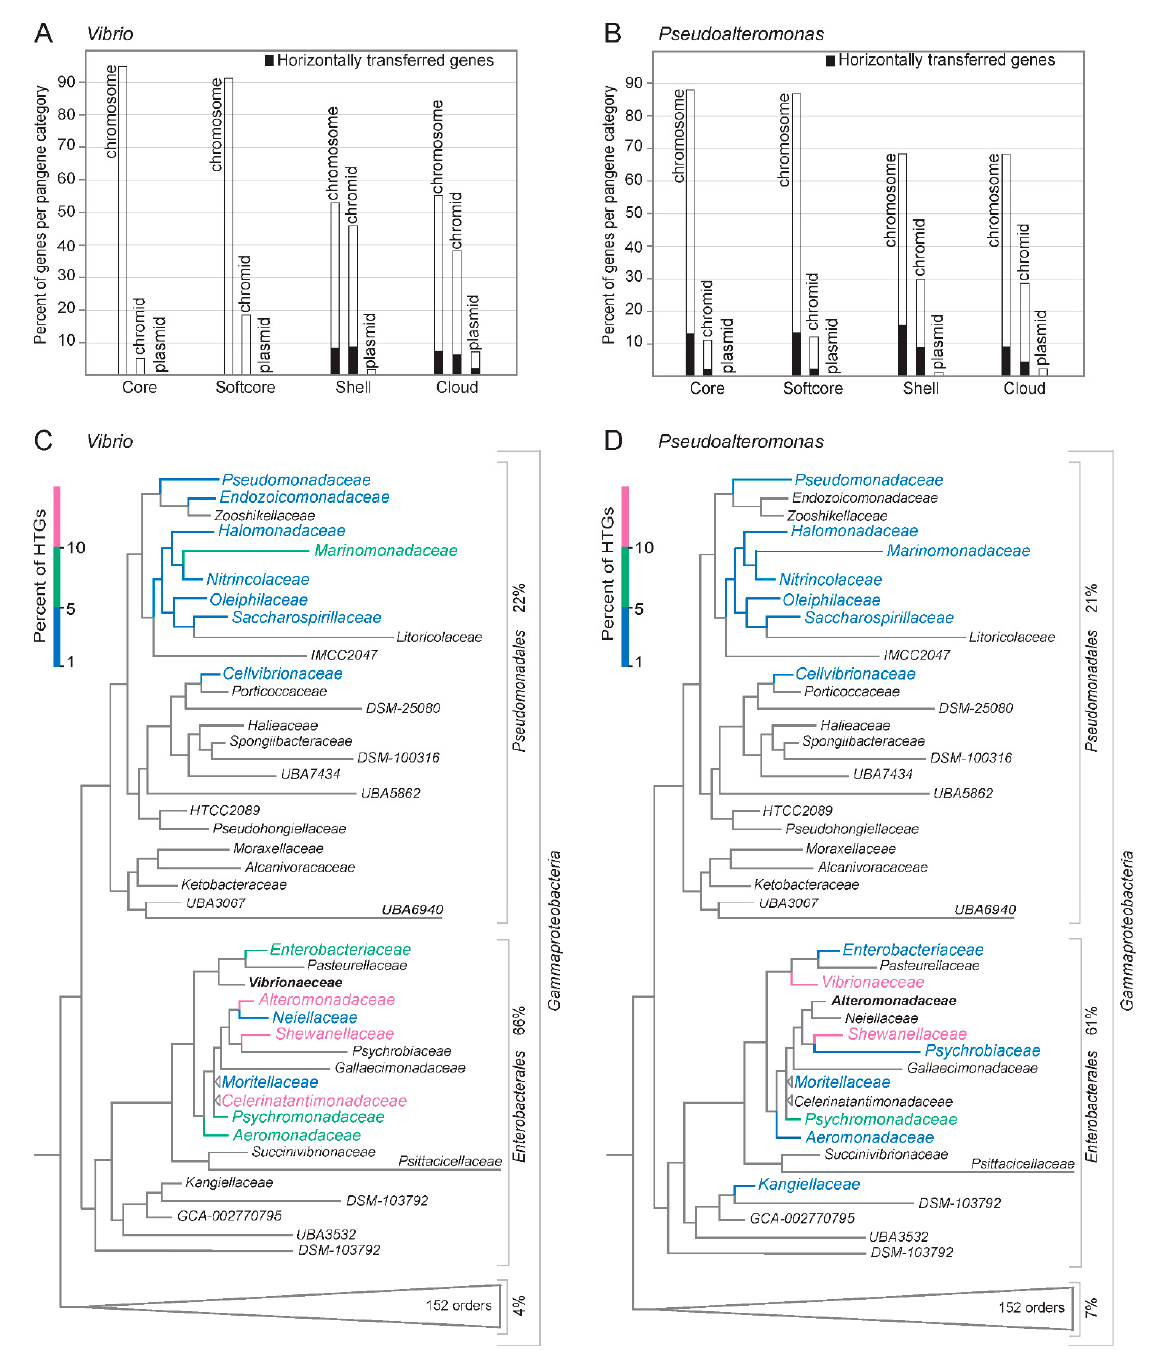
Figure 6. Horizontally transferred genes in Vibrio and Pseudoalteromonas, and the phylogenetic distribution of their donors. The number of HTGs in Vibrio ( A ) and Pseudoalteromonas ( B ) were predicted using the HGTector software. The data is shown as percentage of HTGs in each pangene category (core, softcore, shell and cloud), and also they are distributed among the three types of replicons (chromosomes, chromids and plasmids). HTGs were defined as genes with closest BLASTp hits outside of its family (i.e., Vibrionaceae and Alteromonadaceae , respectively). Next, the predicted bacterial donors of HTGs that reside in Vibrio ( C ) and Pseudoalteromonas ( D ) are shown mapped onto a phylogeny of Gammaproteobacteria . The top donors are shown in colorblindness-friendly color codes, from 1–5% (blue), 5–10% (green) and 10–15% (reddish purple). The majority of HTGs originates from other families within Enterobacterales , with Shewanella (at genus level) as the top donor to both Vibrio and Pseudoalteromonas